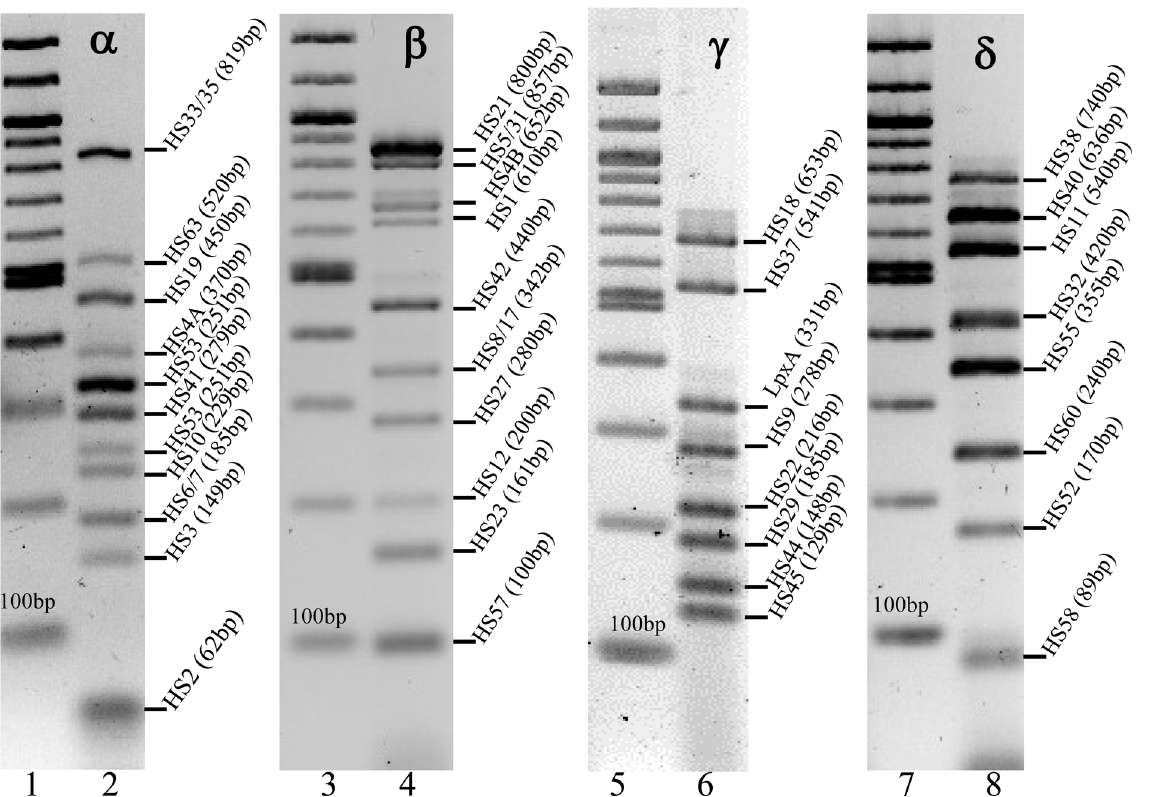
Fig 3. Illustration of PCR amplicons expected when using the updated C . jejuni CPS multiplex PCR. Lane 1, 100-bp NEB DNA standard; lane 2, mixture of PCR products obtained with all the templates from the alpha mix; lane 3, 100-bp NEB DNA standard; lane 4, mixture of PCR products obtained with all the templates from the beta mix; lane 5, 100-bp NEB DNA standard; lane 6, mixture of PCR products with all the templates from the gamma mix; lane 7, 100-bp NEB DNA standard; lane 8, mixture of PCR products with all the templates from the gamma mix.